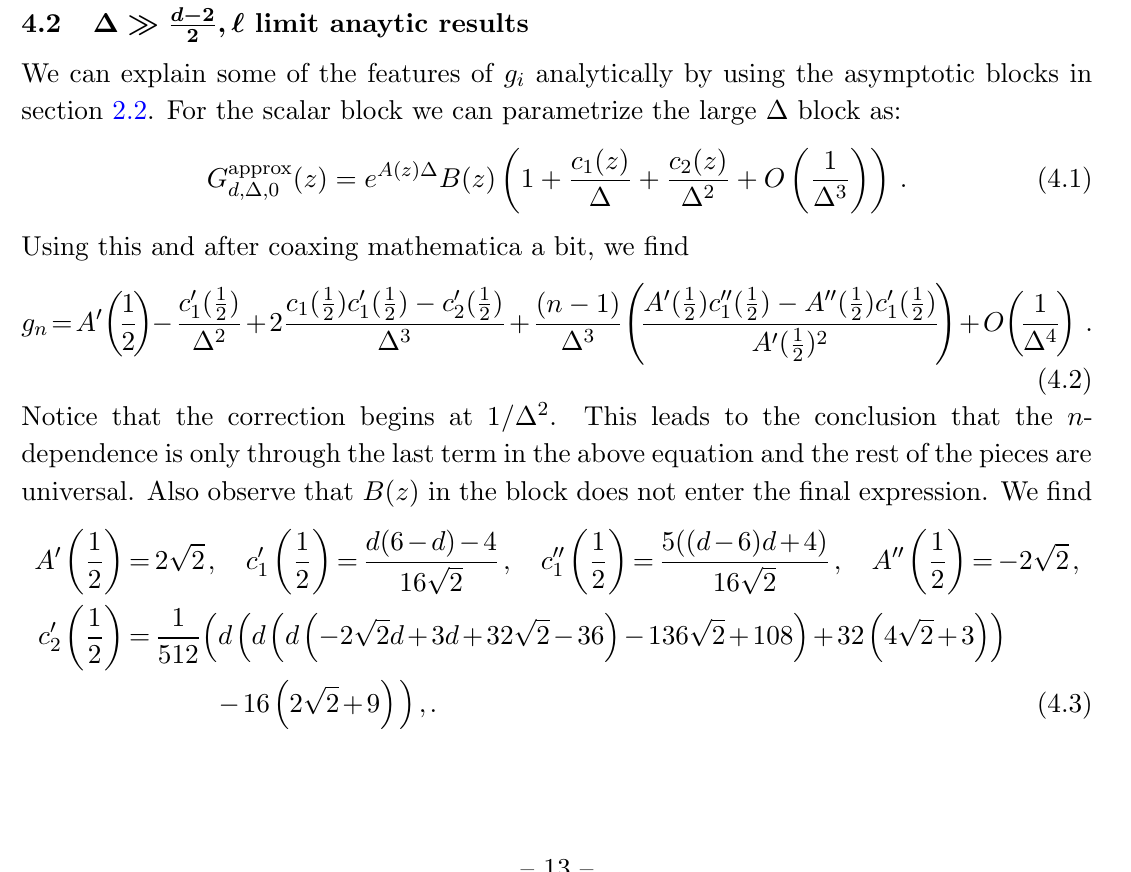
Figure 4. g i vs (cid:1) for scalar blocks for various d , plot range is (cid:1) > d (cid:0) 2 exhibited where it can be expected that eventually all g i ’s become positive for some (cid:1). For d = 2 such a trend does not exist and one is forced to check eq. (3.15)